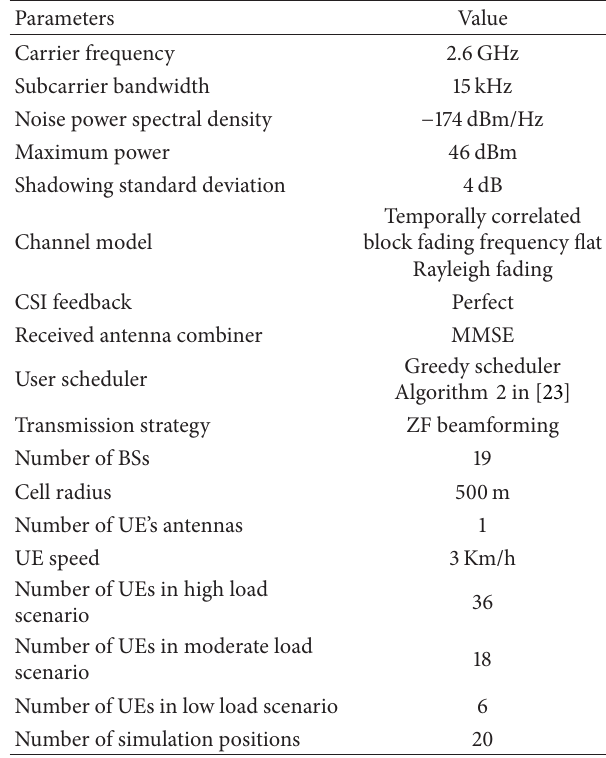
Table 1: Simulation parameters